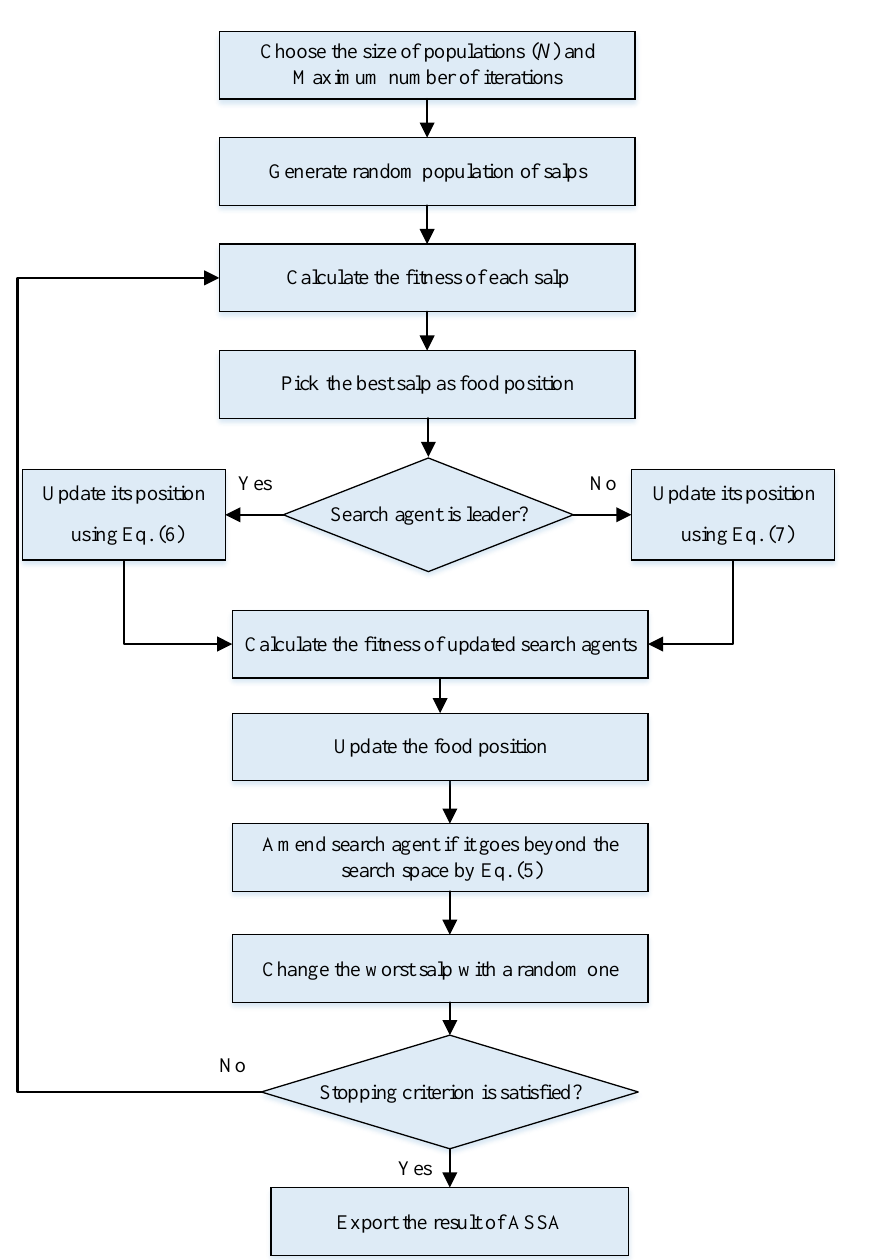
Figure 1. Flowchart of